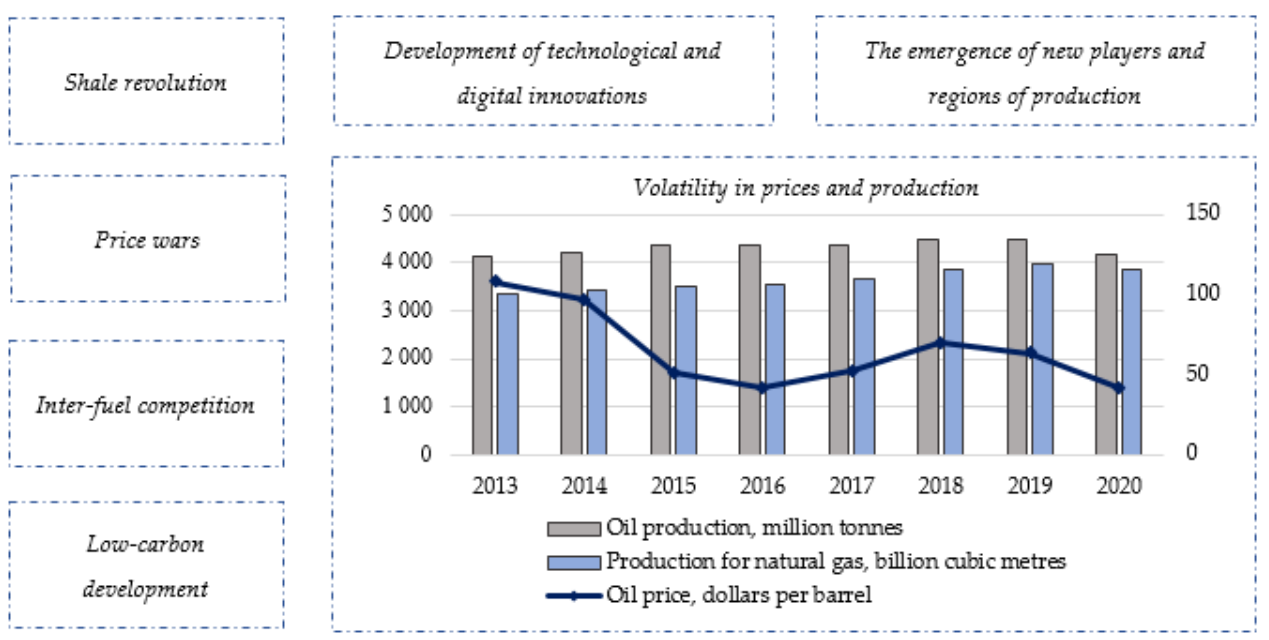
Figure 2. Factors of global instability and changes in the key indicators of the global oil and gas market. Source: created by the authors with the use of [87].